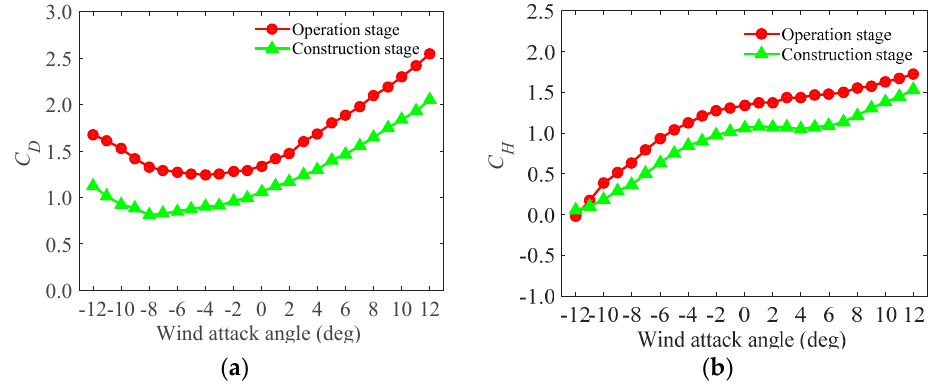
Figure 5. The drag force coefficients of the test models under different wind attack angles: ( a ) in local coordinate system; and ( b ) in global coordinate system. Sensors 2017 , 17 , 335